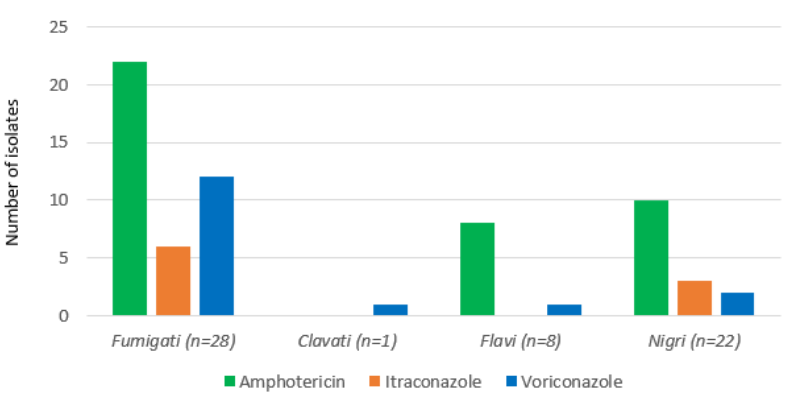
Figure 2. Resistance profiles of Aspergillus in each section. Fumigati and Nigri sections showed resistance in all three classes of antifungals (amphotericin B, voriconazole and itraconazole). There is no itraconazole resistance detected from the Flavi section .